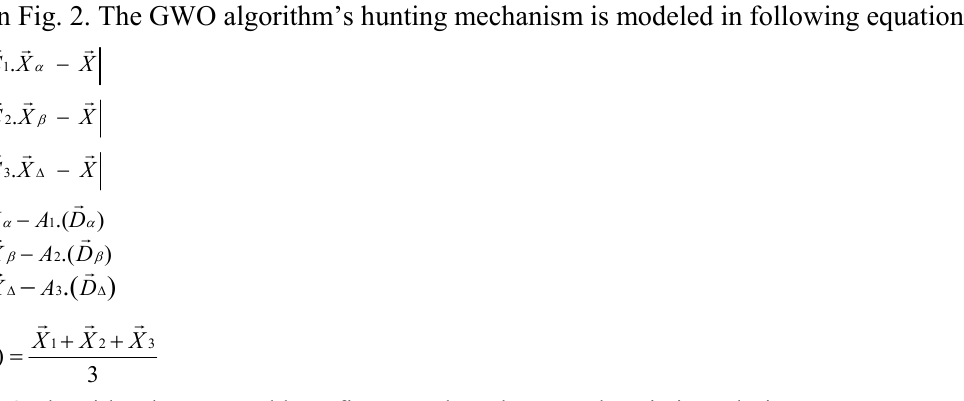
Evaluation of the fitness function for the search agents ( α , β , Δ , and ω )